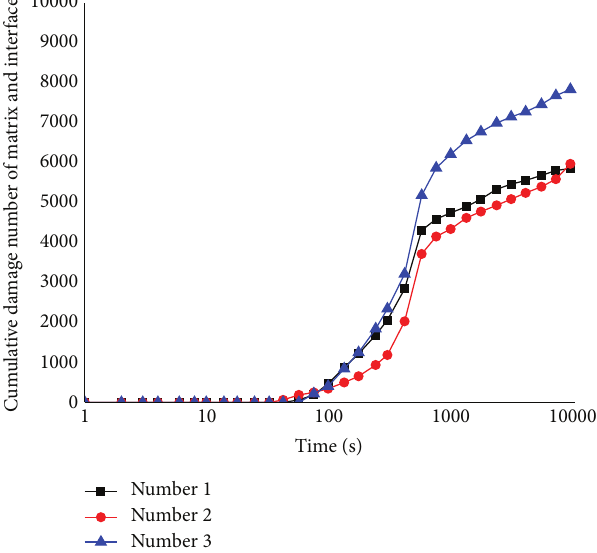
Figure 10: Change of cumulative damage number of matrix and interface with the tensile loading